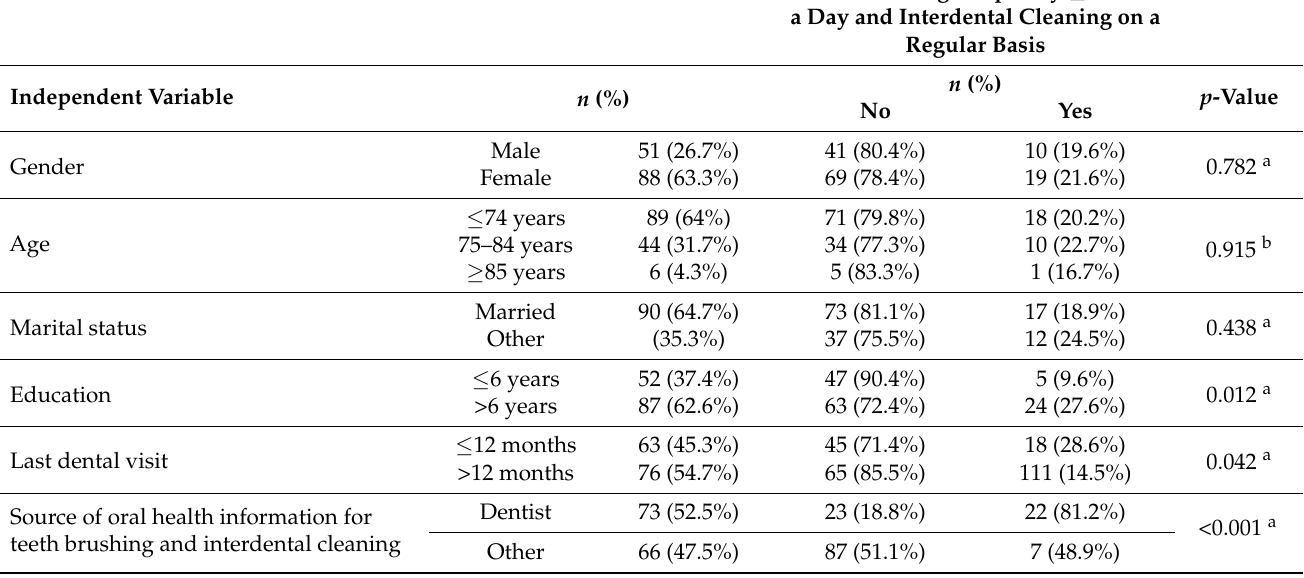
Table 8. The association of sociodemographic characteristics, dental visitation habits and source of daily dental hygiene information with toothbrushing frequency at least twice a day and interdental cleaning at least once a day.